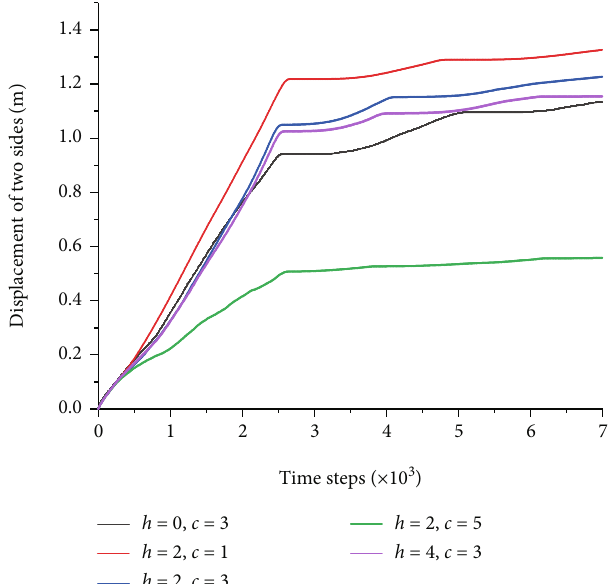
Figure 13: Displacement of two